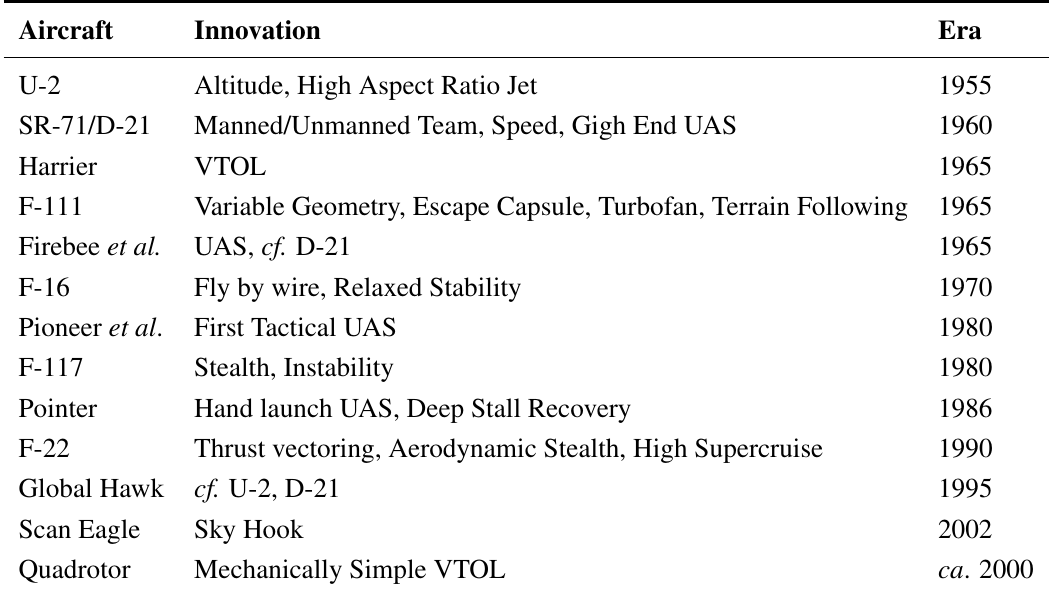
Table 1. List of aircraft, the innovation with which they were equipped, and the approximate